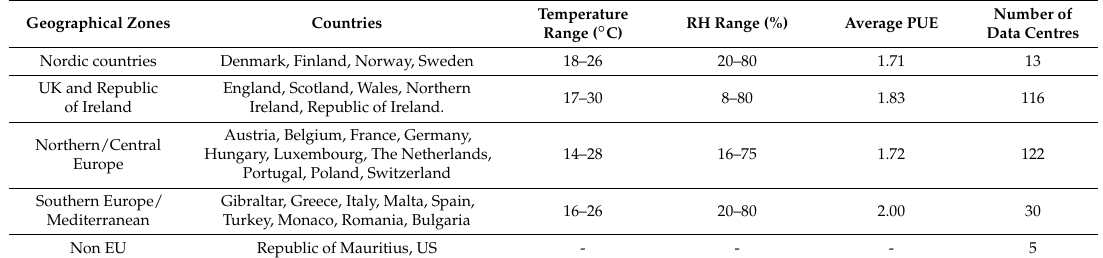
Table 3. Geographical zoning with temperature and relative humidity average